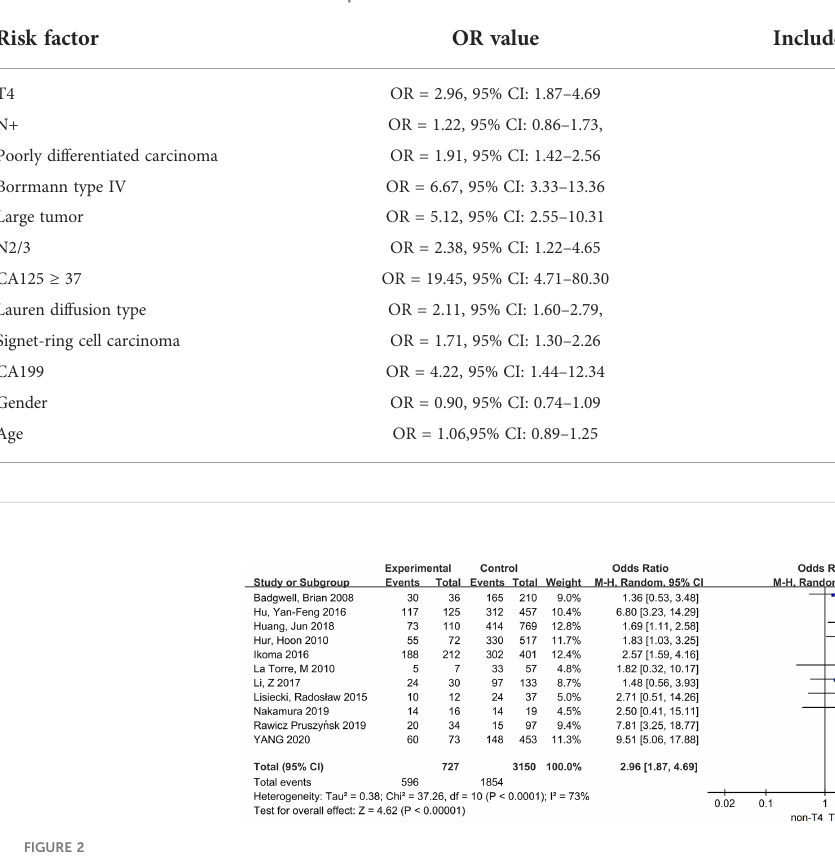
FIGURE 2 The correlation between T4 stage and PC.